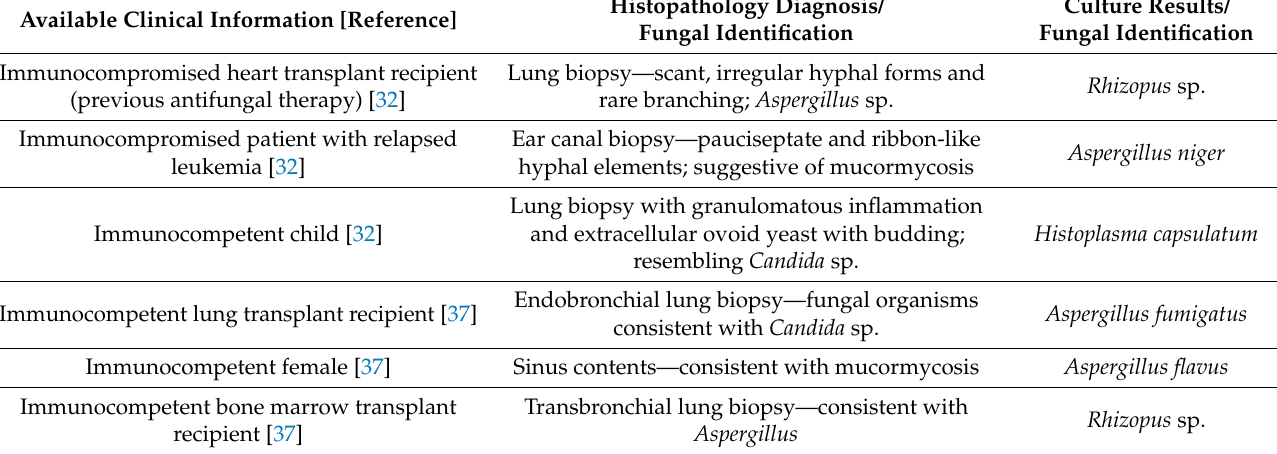
Table 1. Examples of cases from studies where identification of the etiologic agent by histopathology differed from culture or other laboratory